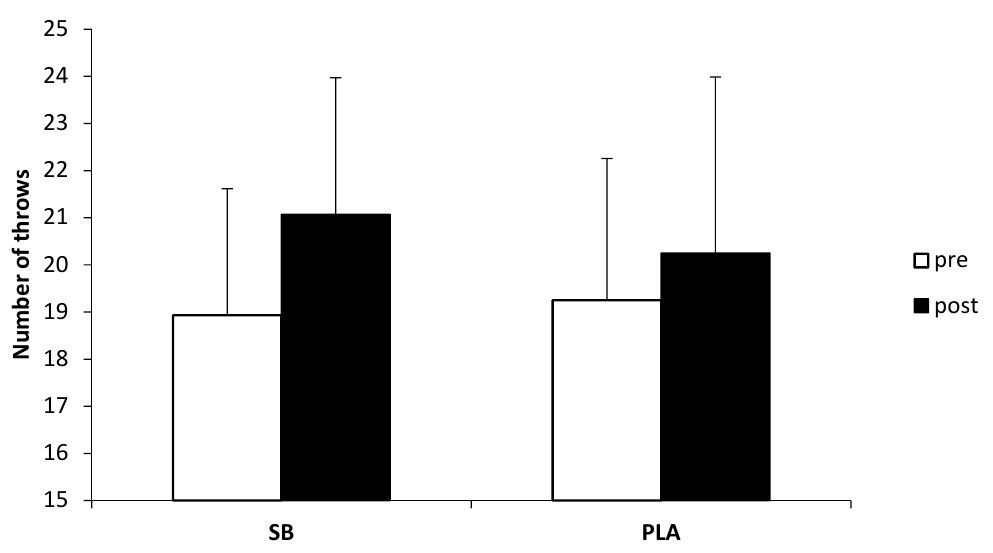
Figure 3. Total number of throws in the dummy throw test. SB—sodium bicarbonate group; PLA—placebo group.